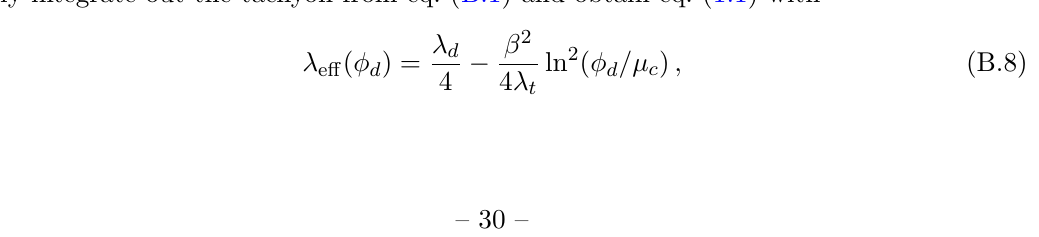
Figure 9 . Masses of the two scalars, that play the role of S 1 and S 2 , as a function of (cid:22) c = h (cid:30) d i and normalized to (3 (cid:25)= 4) h (cid:30) d i . We have taken (cid:21) = 1, ^ (cid:20) 2 = 6 and ^ m 2 blue and red lines respectively. The solid (dashed) line indicate the lightest (heaviest) mode. The quartic coupling (cid:21) d varies along the horizontal axis according to eq. (B.5). The vertical line marks where (cid:21) d = 0, having (cid:21) d > 0 in the region to the right of it. while for (cid:12) 2 = ( (cid:21) (cid:21) ) (cid:29) 1 these t d